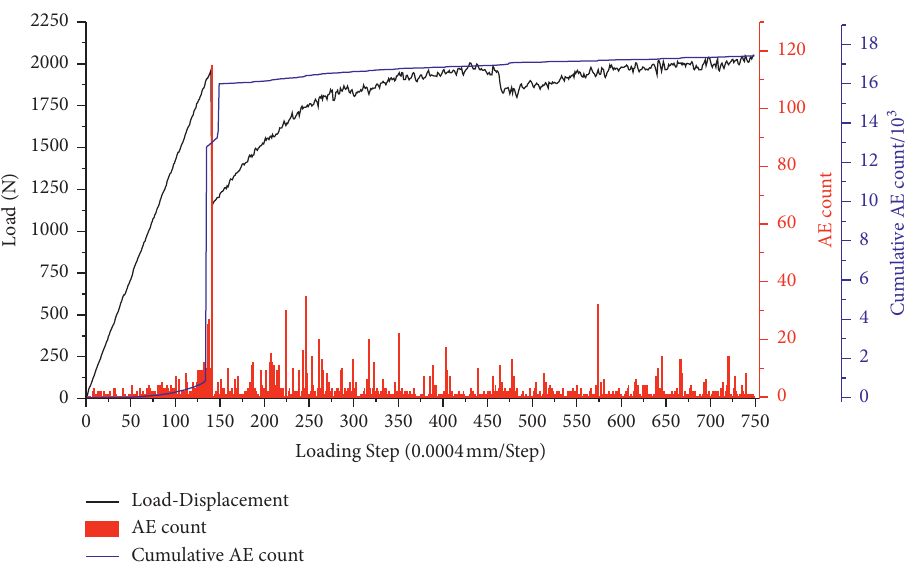
Figure 8: Load-AE and cumulative AE displacement curves of a particle under diametral loading with